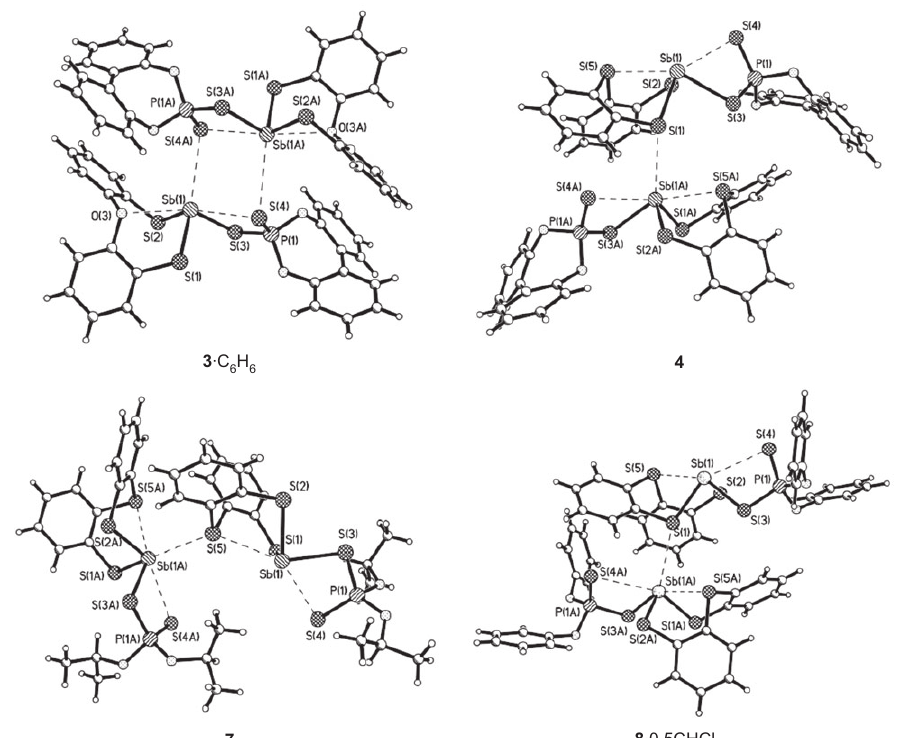
Figure 3 Supramolecular associations observed in compounds 3 , 4 , 7 , and 8 . The solvent molecules in 3 and 8 have been